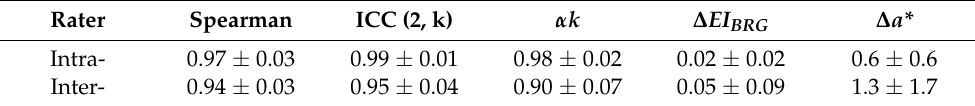
Table 3. Mean and SD of the intra- and inter-rater reliability coefficients (Spearman’s r s , intra-class correlation (ICC), and α k ). Absolute agreement ( ∆ ) is listed for two EIs: EI BRG and a* of the CIELAB color space.